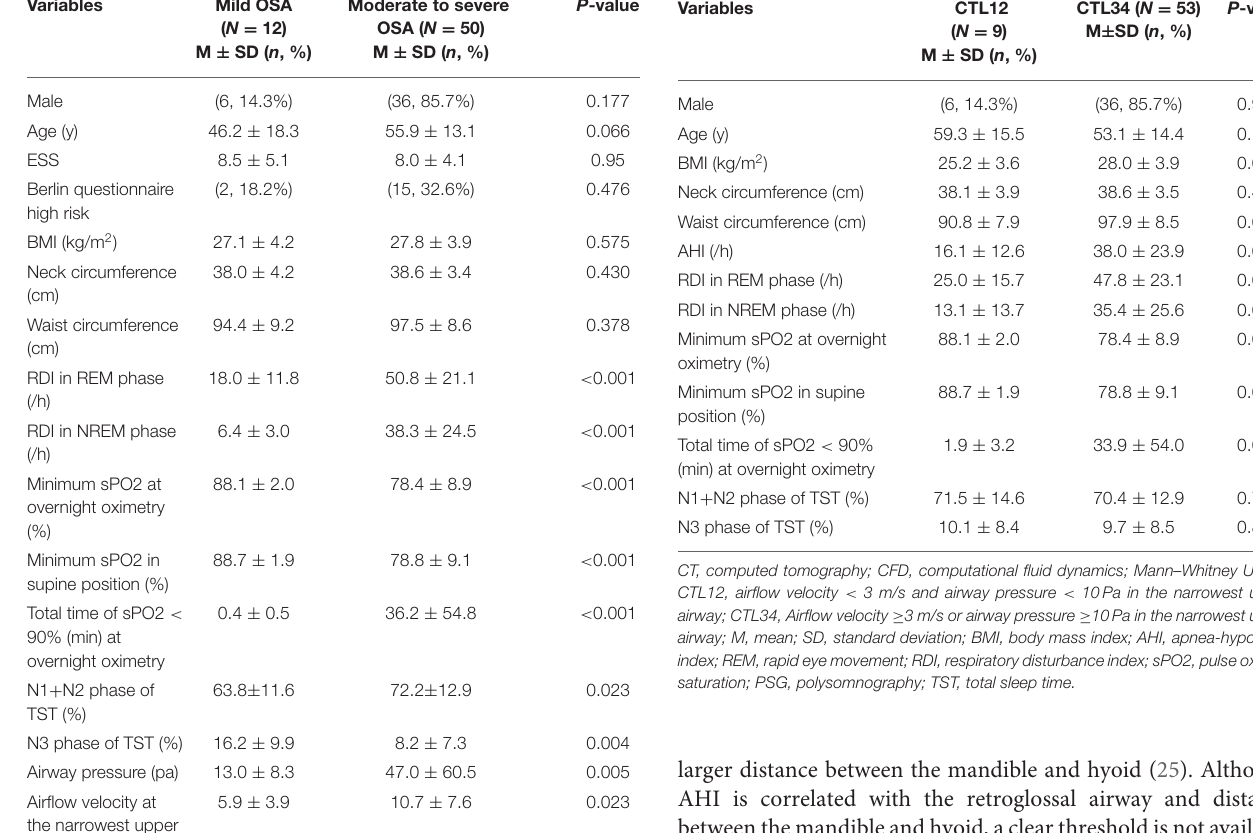
TABLE 3 | Results for patients with CTL12 or CTL34 as determined using awake neck CT with CFD study. Variables CTL12 ( N =